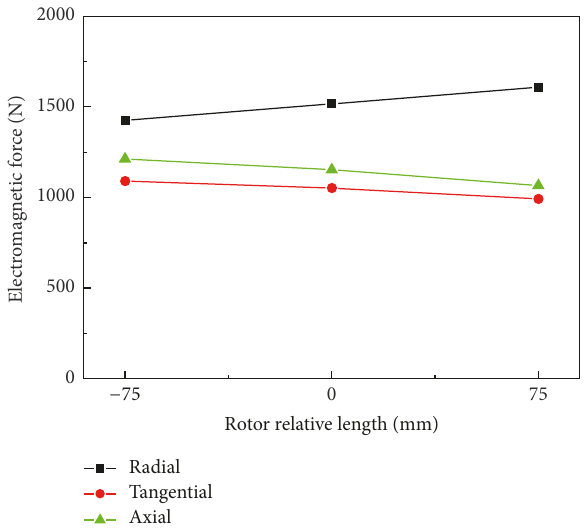
Figure 11: Electromagnetic forces on the involute part with different rotor relative